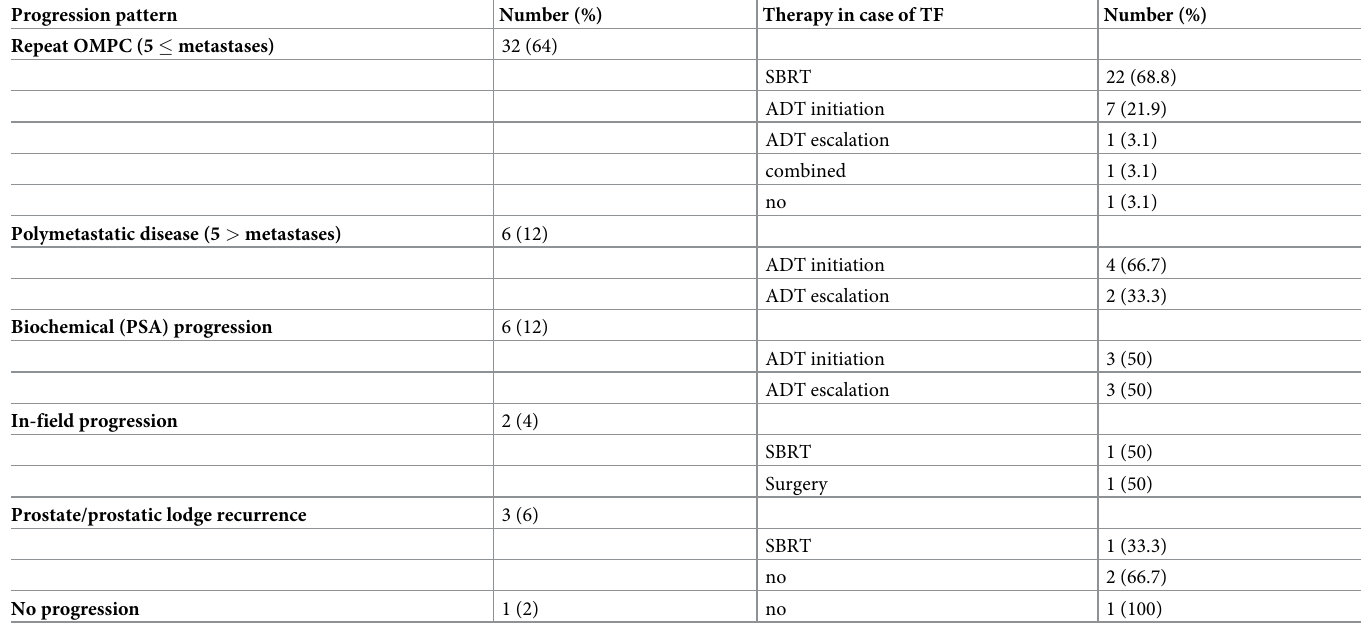
Table 2. Progression pattern and therapy initiated in case of treatment failure in all